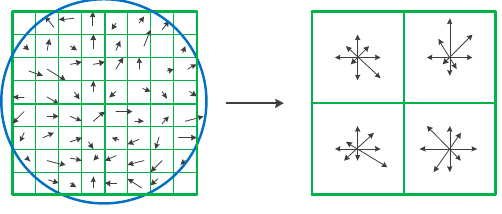
Figure 1. Directions of the keypoints.